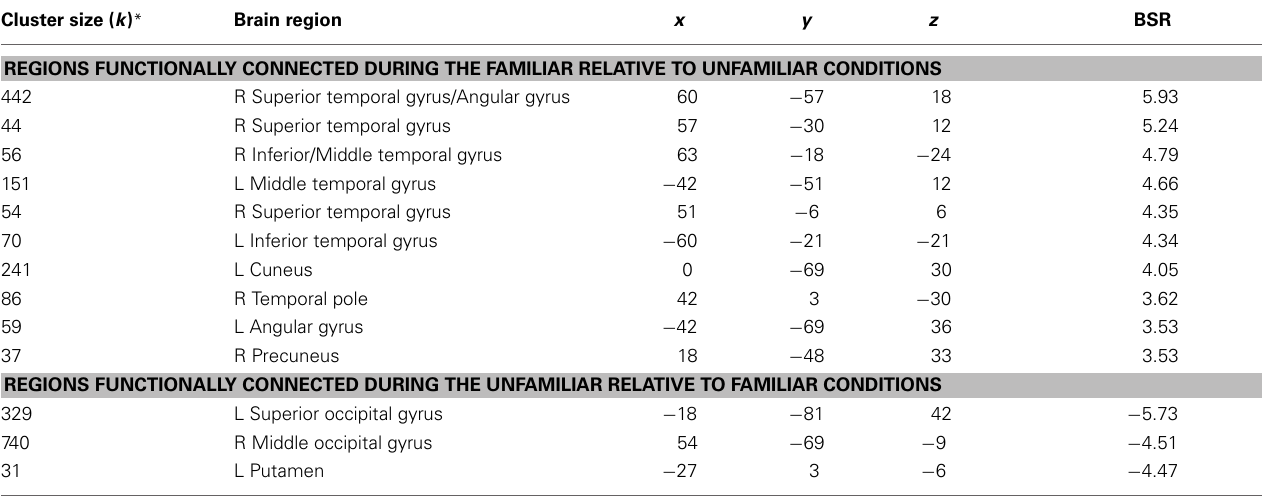
FIGURE 3 | Regions functionally connected with the right perirhinal cortex seed. A seed PLS analysis demonstrated that the functional connectivity of the right perirhinal cortex differed depending on stimulus familiarity. (A) Regions shown in red are those with which the right perirhinal cortex seed was functionally connected during the two familiar conditions in TR 3, whereas (B) displays regions shown in blue with which the perirhinal Table 3 | Regions showing significant functional connectivity with the right perirhinal cortex